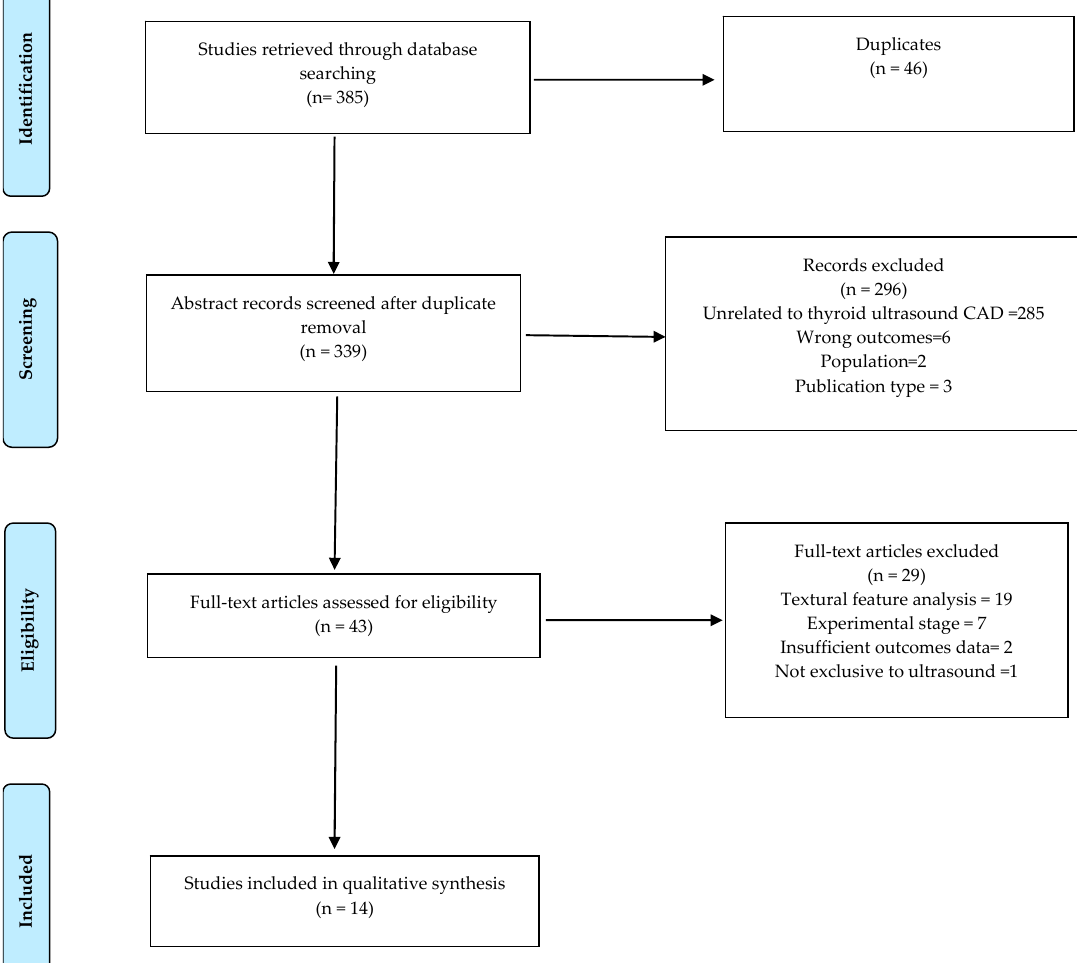
Figure 1. Flow chart of the study selection proc